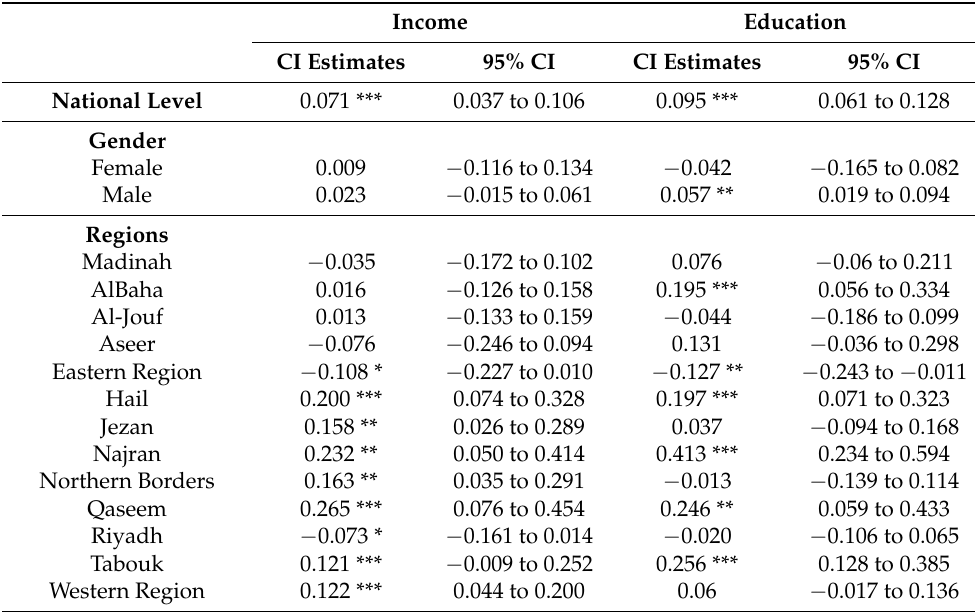
Table 3. Wagstaff et al. inequality indices, by income and education, for